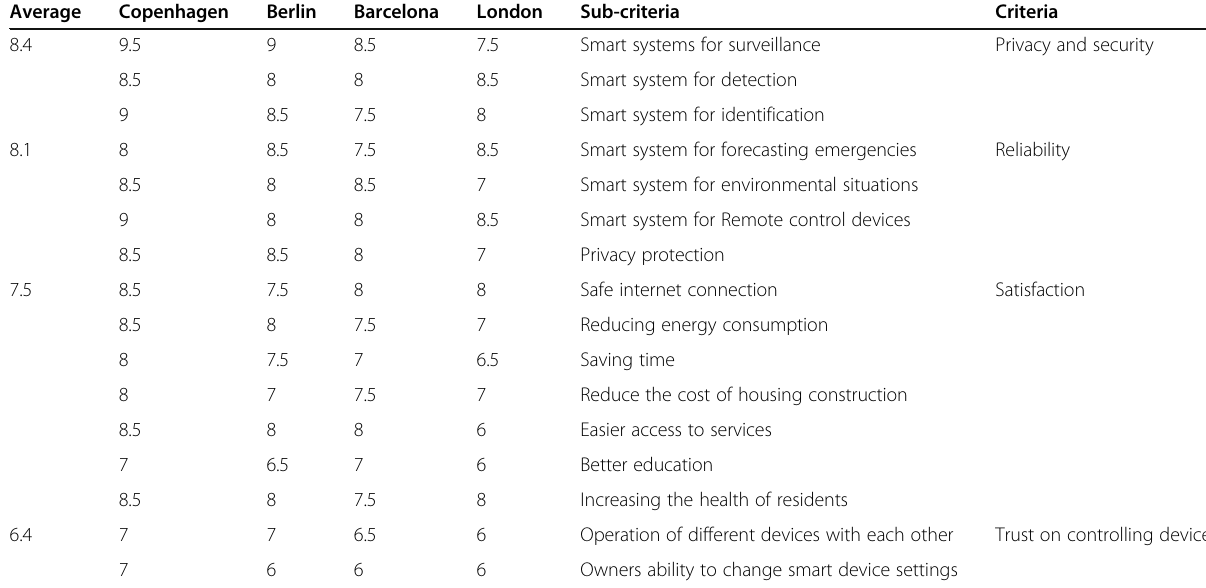
Table 12 The average rating of each of the criteria and sub-criteria